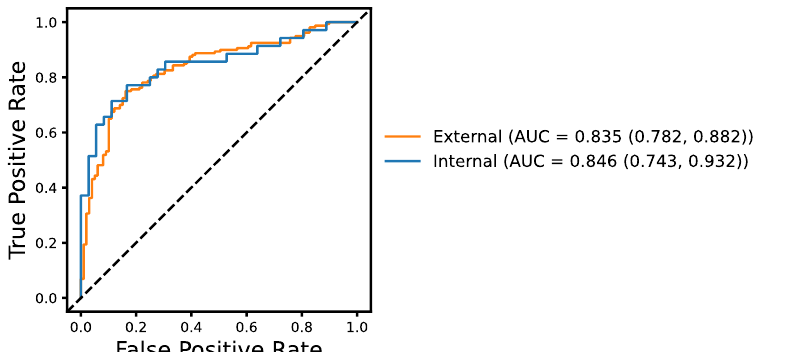
Figure 5. ROC curves and the corresponding AUC scores of the neural network (NN) classifier on the external DementiaBank Pitt dataset and internal unseen ADReSSo test set. 95% confidence interval is also reported for the AUC score.